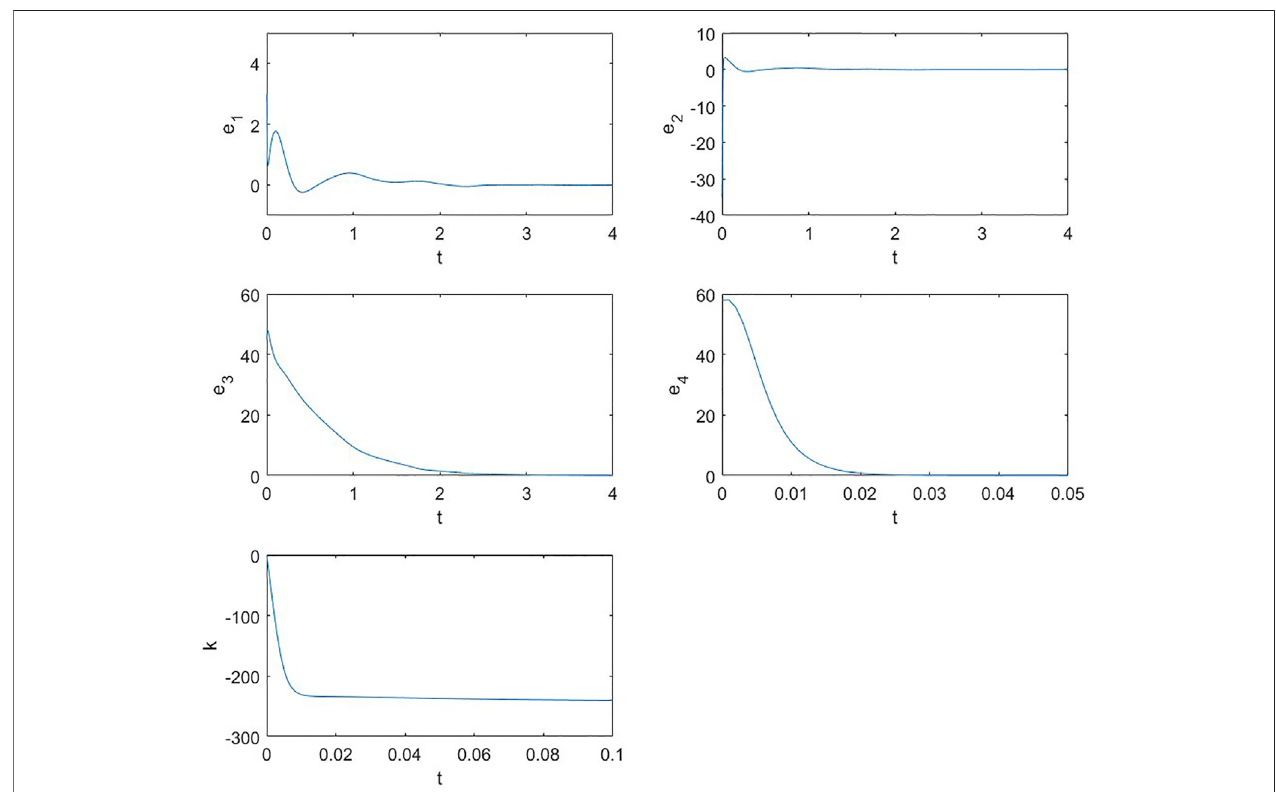
FIGURE 4 | Error synchronization by the control law ( Eq. 17 ) associated with ( Eq. 18 ).